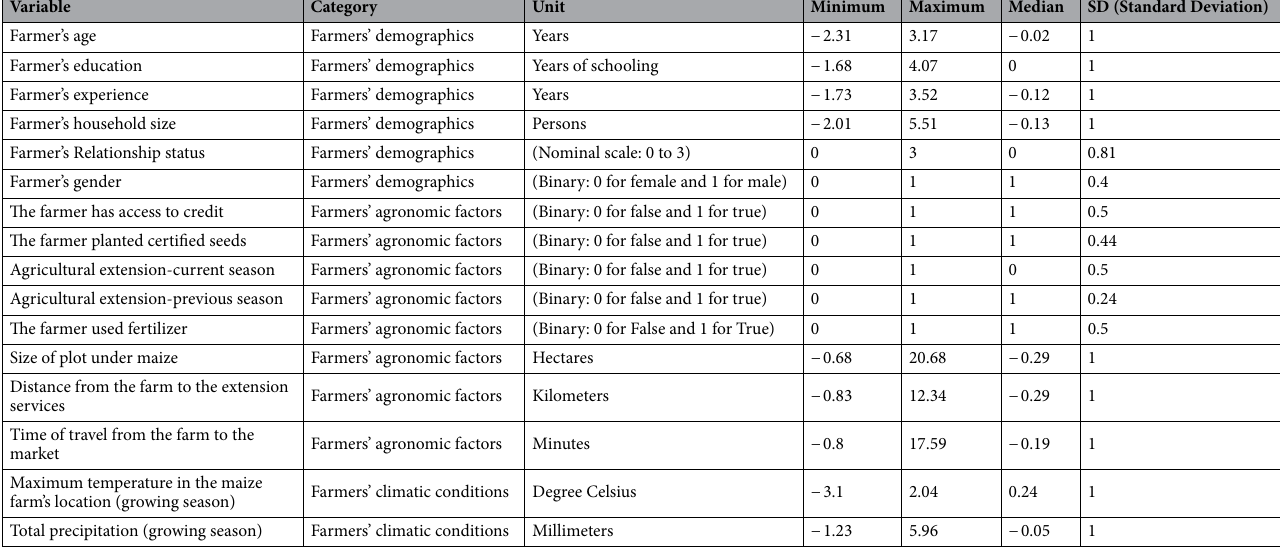
Table 2. Summary of study data characteristics after